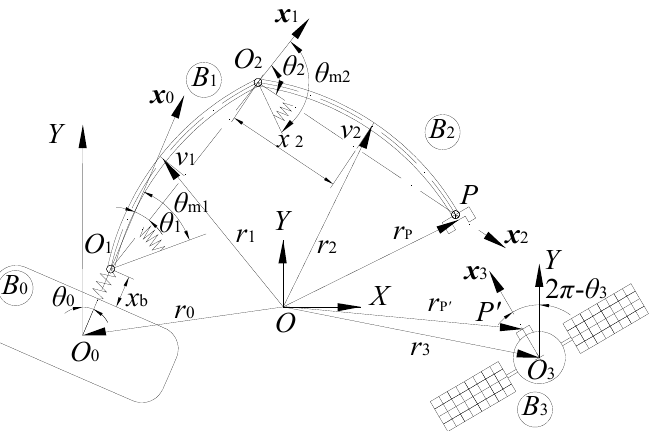
Figure 1. Structure of the flexible-base, flexible-joint and flexible-link space robot and the satellite. According to the hypothesis of Spong [26], the flexible base and joint are assumed to be a massless linear telescopic spring and linear torsion spring, respectively. The flexible links are equivalent to the Euler Bernoulli simply supported beam. The elastic coeffi- cients of the base, joints and bending rigidity of the links are fixed, which are expressed k and EI ( 1,2) j = , respectively. The deformation of link B is as b k , mj j j φ δ , where and represent the k th-order modal function jk jk = B , respectively, and n is the number of reserved modes ( 2 n = and coordinates of link j in the paper). r , r , r , r , r 0 1 2 P 3